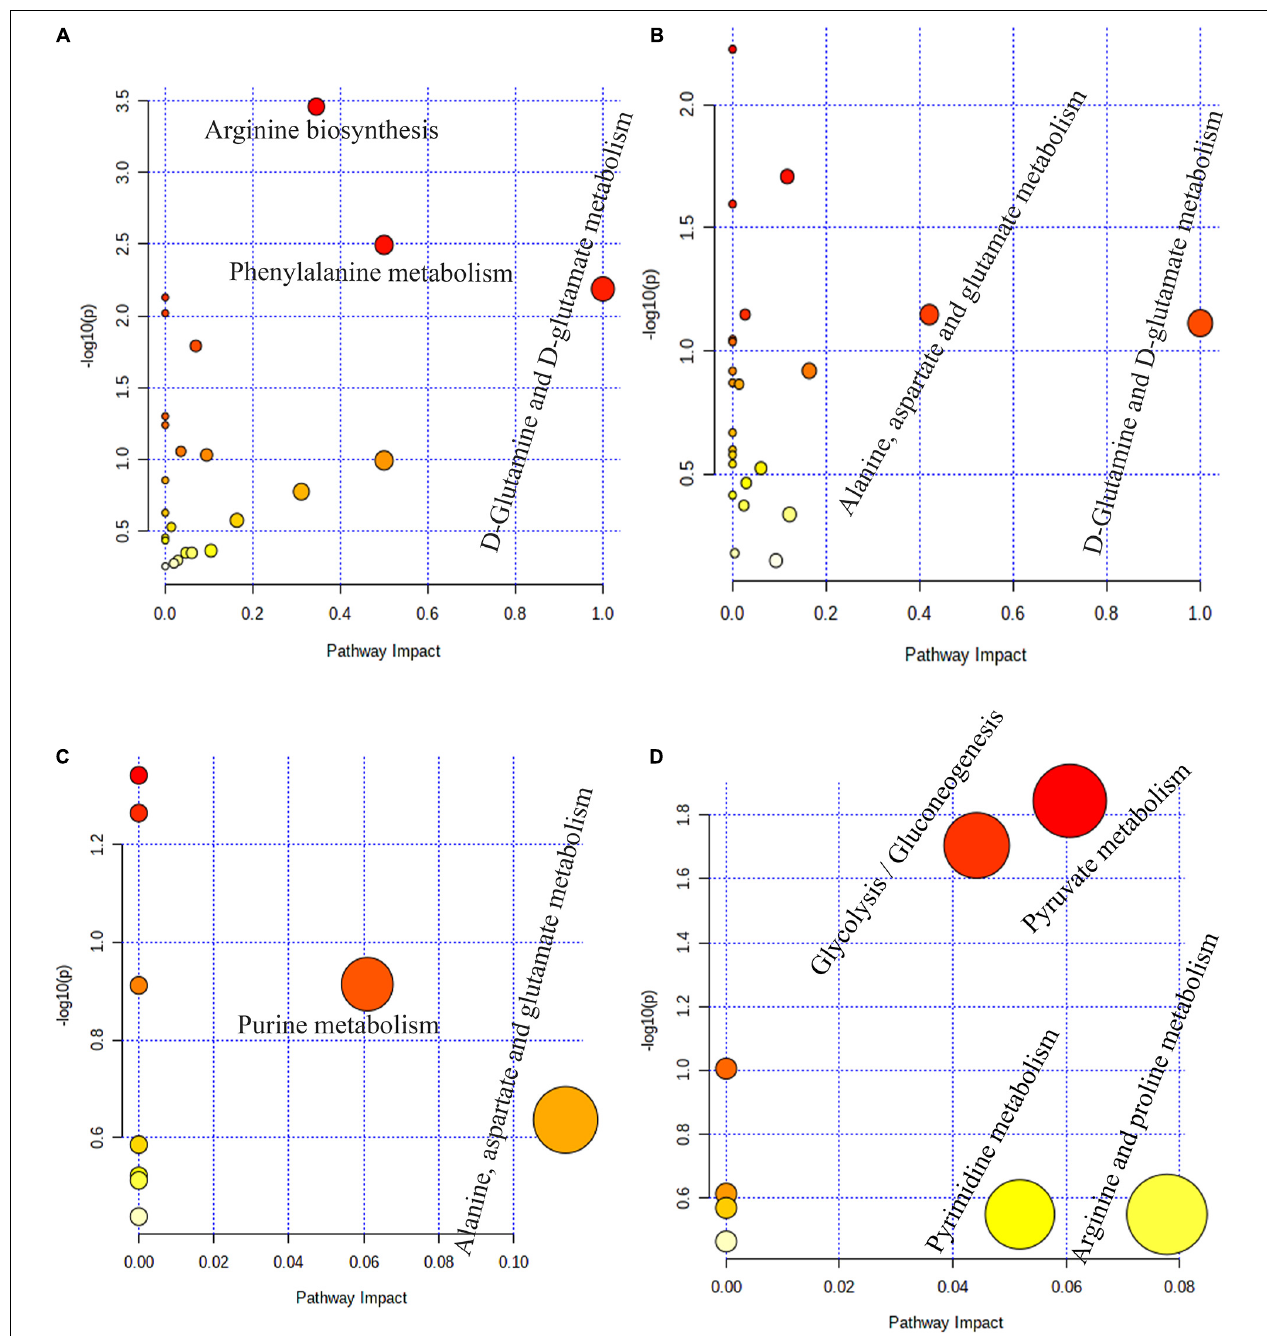
FIGURE 5 | Pathway enrichment analysis based on stomach different metabolites. Pathway enrichment analysis performed using the significantly different metabolites between MSTN + / − and WT cattle in rumen (A) , reticulum (B) , omasum (C) and abomasum (D) .